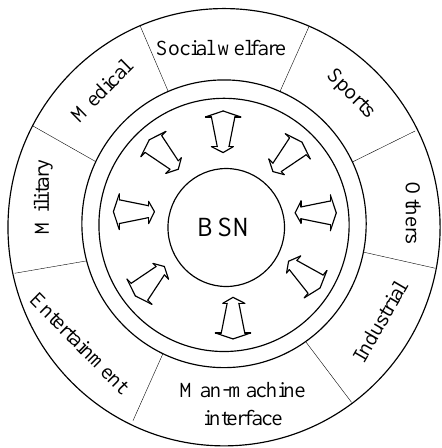
Figure 4. Application fields of